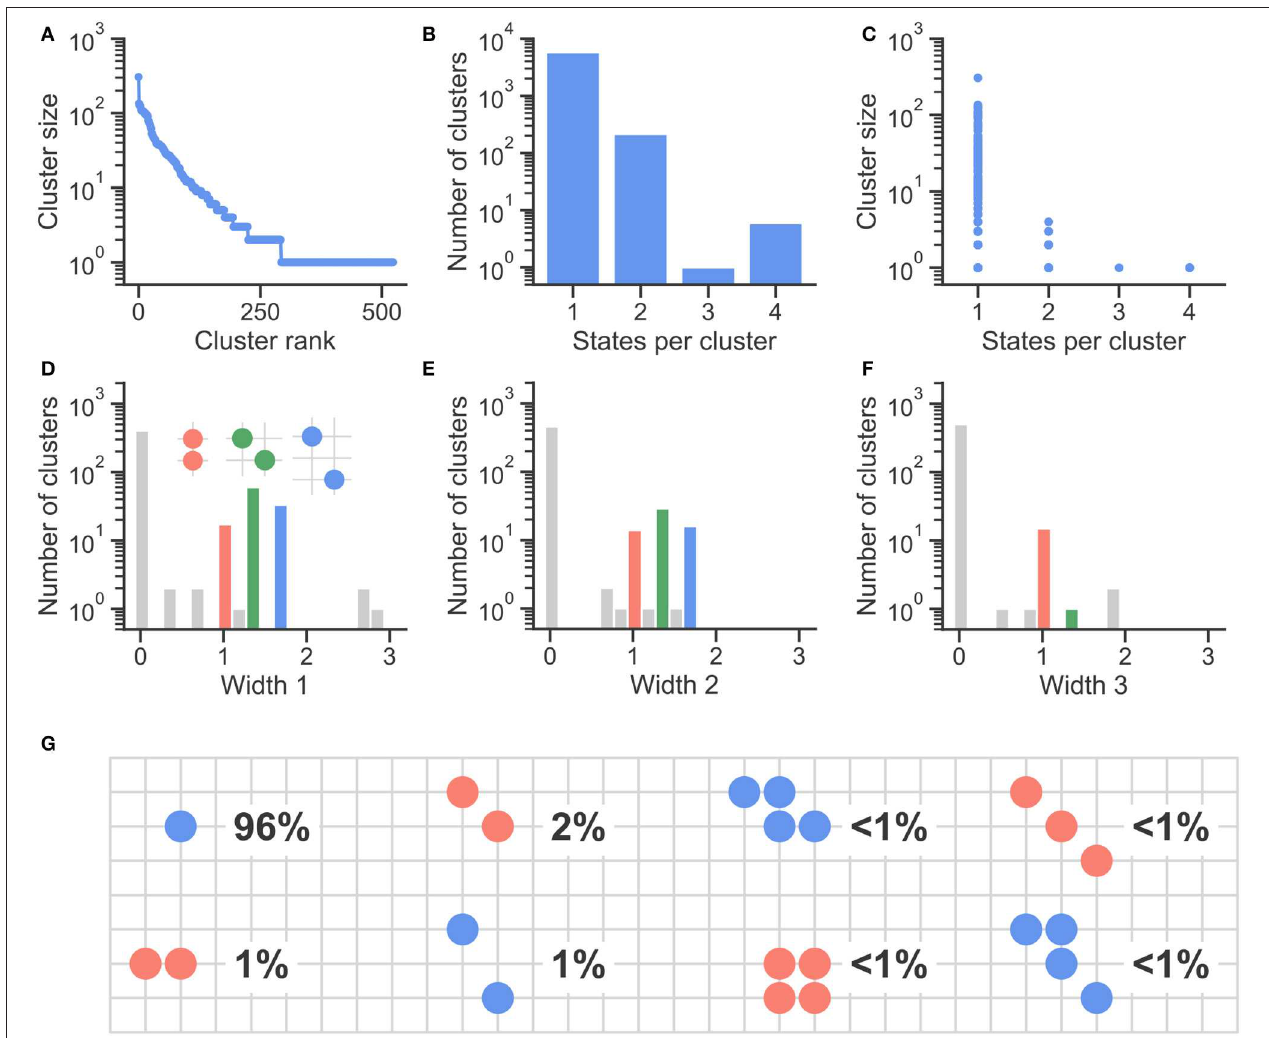
FIGURE 3 | Examining all steady-state distributions for 20 runs of every M 5, N 3 matrix. (A) Shows a rank plot indicating the range of cluster sizes, i.e., the = = number of runs producing each steady-state distribution. (B,C) Show a breakdown of the number of states (i.e., points in attitude space) per cluster: the number of clusters with a single state is over one order of magnitude above the number of clusters with two or more states, and those one-state steady states are also the ones corresponding to the largest number of runs, as shown in (C) . (D–F) Count the number of clusters according to their width in each cluster’s widest axis [Width 1, (D) ], followed by its second and third widest axes [widths 2 and 3, (E,F) , respectively]. In order, red, green, and blue bars indicate clusters with width 1, √ 2, and √ 3, as indicated by the insets in (D) . (G) Shows the frequency of different steady-state distributions, when clustered only on their shape, but not on their position in attitude